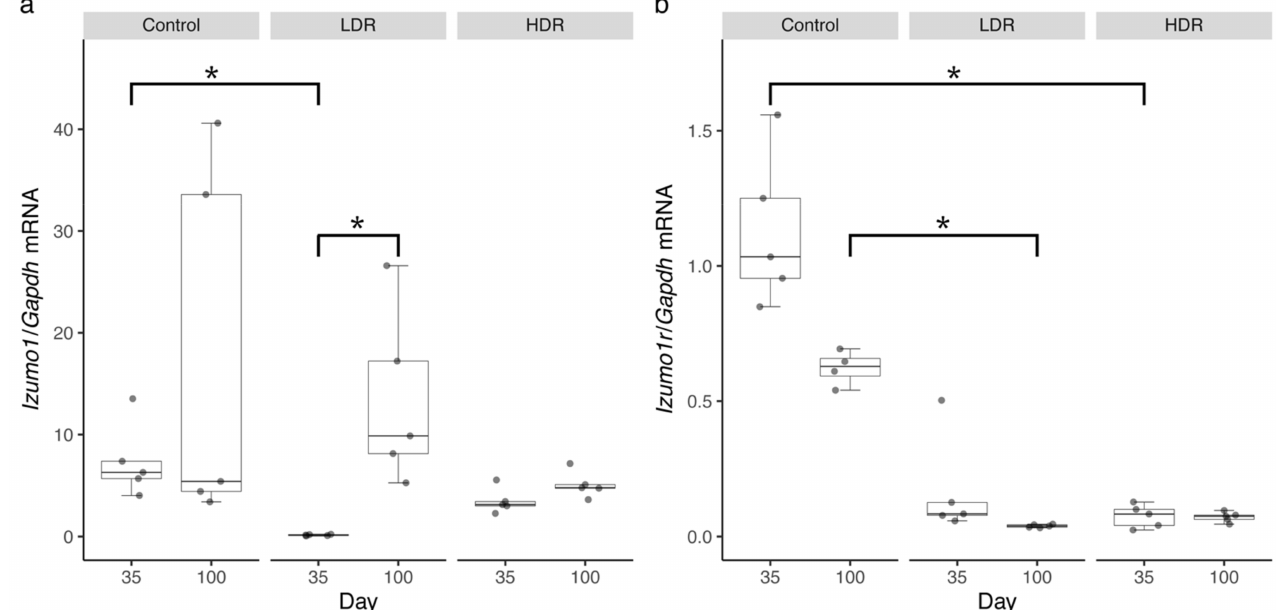
Figure 2. Expression levels of Izumo1 ( a ) and Izumo1r mRNA ( b ) in male and female mice following radiation exposure. Gapdh was used as the endogenous housekeeping control. * Significant difference at p < 0.05. Sample medians are shown by the center line and crosses, respectively. Box edges represent the 25th and 75th